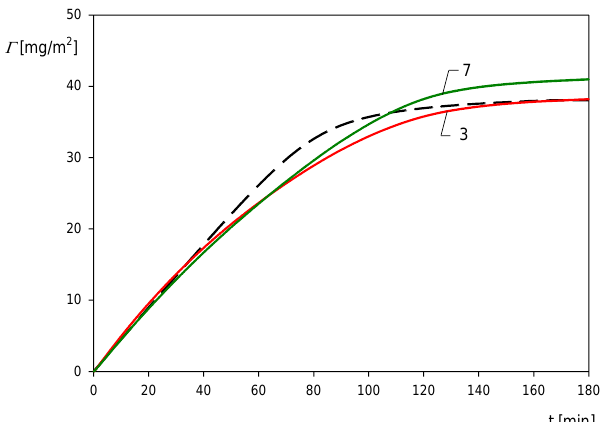
Figure 11. Kinetics of the polymer particle with HSA corona deposition on the gold sensor under flow conditions: the corona coverage 0.80 mg m − 2 , pH 4, 10 mM NaCl, c b = 50 mg L − 1 , flow rate 2.5 × 10 − 3 mL s − 1 . The solid red line shows the corrected QCM result for the third (red line) and the seventh overtone (green line), and the black dashed shows the theoretical results calculated from the RSA model.